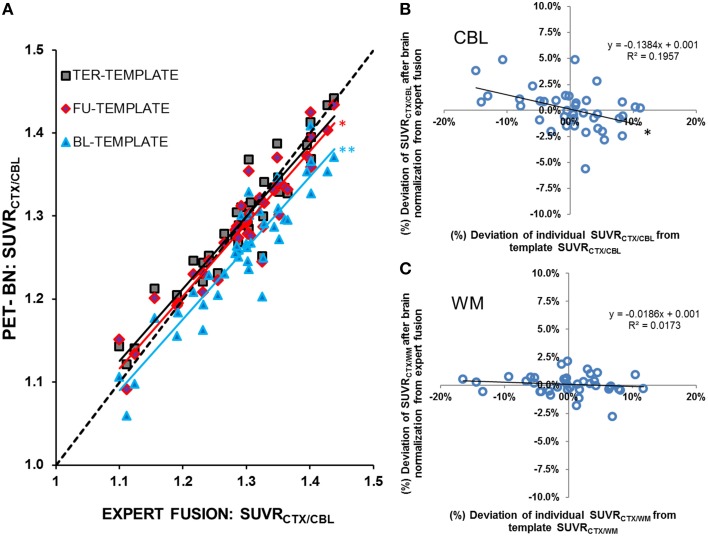
(A) SUVRCTX∕CBL from N = 40 PS2APP mice aged 13–16 months after brain spatial normalization to a stage-specific (high) tracer uptake template (TER-TEMPLATE, black-gray squares), an intermediate tracer uptake template (FU-TEMPLATE, red-purple diamonds) and a low tracer uptake template (BL-TEMPLATE, blue triangles). Lower uptake templates gave systematic underestimation of SUVRCTX∕CBLafter automated brain normalization when compared to expert fusion. With the stage-specific template, minor underestimations were observed for high SUVRCTX∕CBL and vice versa. Dashed line represents the line of perfect identity (R = 1) between raw expert fusion and brain normalization). Significant differences (paired t-test) resulting from template mismatches vs. the stage specific TER-template are indicated by *p < 0.05; **p < 0.001. Relationships between (%)-deviations of individual SUVRCTX∕REF from the template SUVRCTX∕REF and the (%)-deviation of SUVRCTX∕REF from the expert manual fusion after the brain normalization are illustrated for (B) the cerebellar and (C) the hindbrain white matter reference region. Significant correlation is indicated by *p < 0.01.